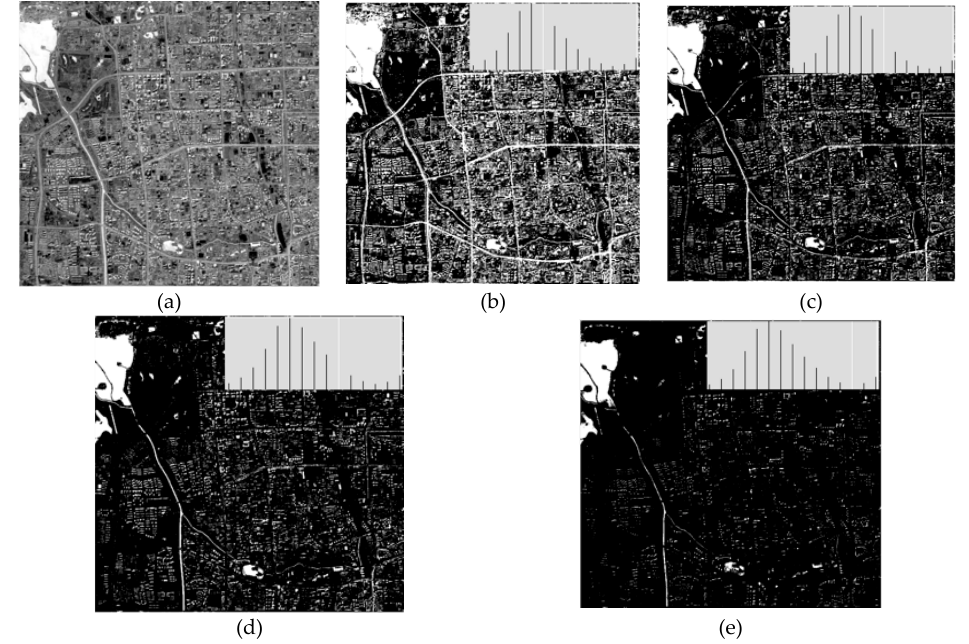
Figure 3. Different segmentation results and adjusted thresholds that used several typical threshold adjustment approaches, ( a ) Water index image, ( b ) Otsu’s method, ( c ) Entropy threshold, ( d ) Yen’s method [34], ( e ) Valley bottom. The sub-image in the right-up ( b – e ) shows the grey histogram of the image and the white line indicates the obtained threshold.